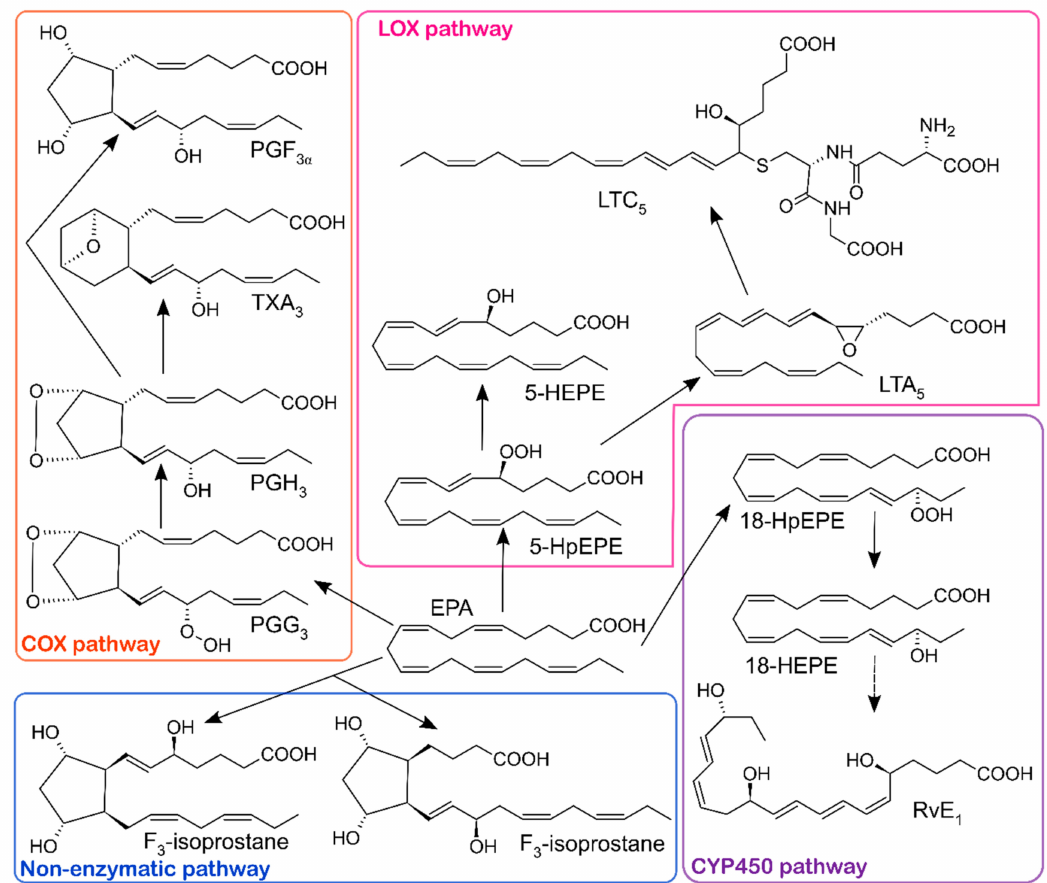
Figure 2. Conversion of EPA into oxylipins by COX, LOX, CYP 450 pathways and by the non-enzymatic pathway. COX, cyclooxygenase; LOX, lipoxygenase; CYP450, cytochrome P450; PGF 3 α , prostaglandin F3 α ; TXA 3 , thromboxane A3; PGH 3 , prostaglandin H3; PGG 3 , prostaglandin